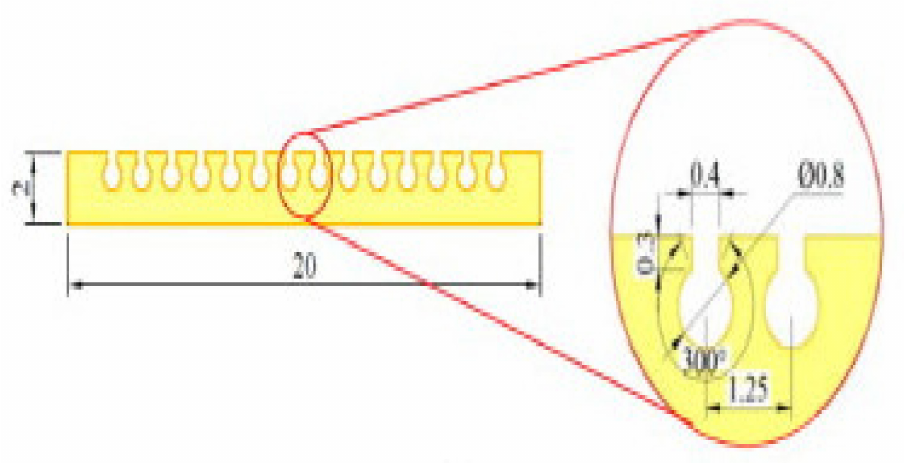
Figure 2. Micro-channel omega shape in mm [61] © Elsevier,